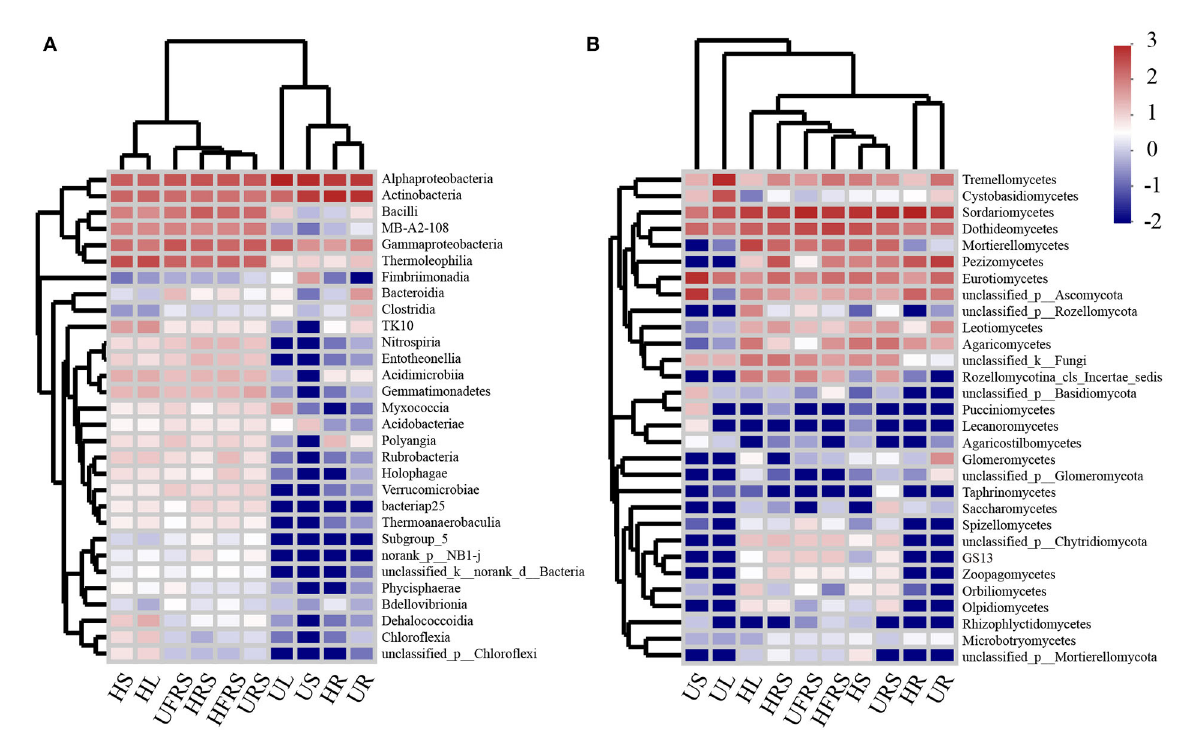
FIGURE5 Heatmap analysis of the top 30 classes of (A) bacterial and (B) fungal communities in the compartments of P. bungeana in healthy and unhealthy plants. Abbreviations of variables are given in Figure